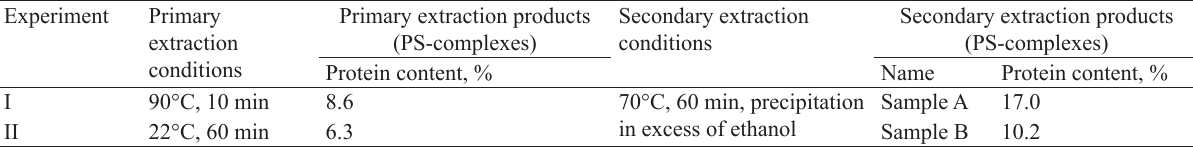
Table 1 Two cycles: primary and secondary extractions from industrial flax seeds